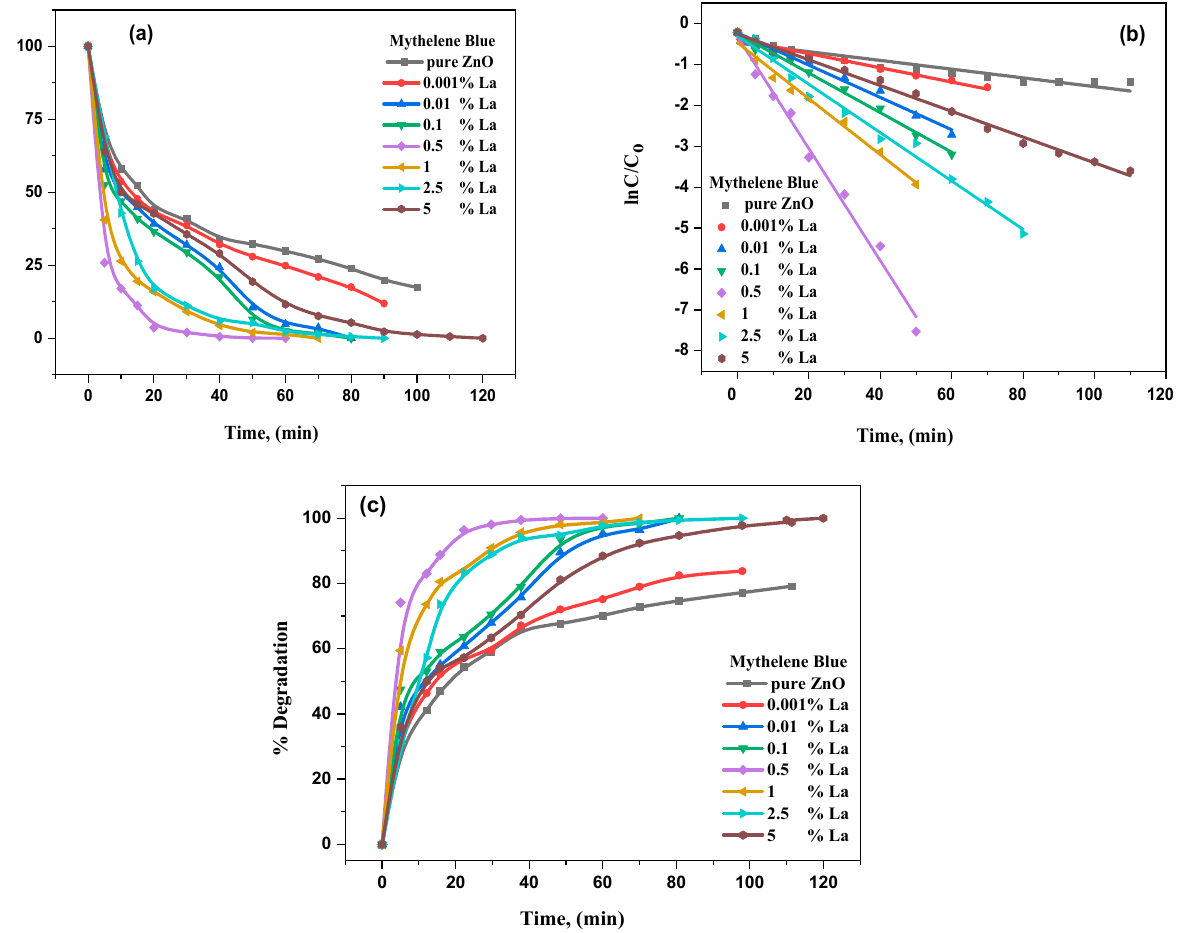
Figure 9. ( a – c ): photodegradation of MB in the presence of pure ZnO and La 2 O 3 -ZnO nanostructured composites, ( a ) concentration of MB with time, ( b ) kinetic study of photodegradation of MB, ( c ) % degradation of MB versus time.